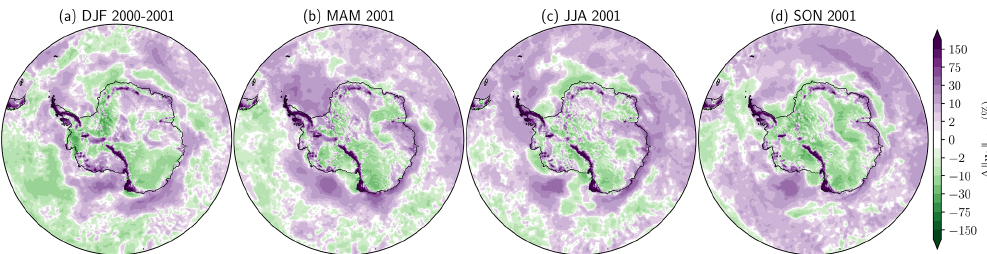
Figure 12. Relative differences in seasonally averaged 10m horizontal wind speed norm between ERA5 and PARASO (i.e., (PARASO– ERA5)/ERA5). Note the nonlinear color